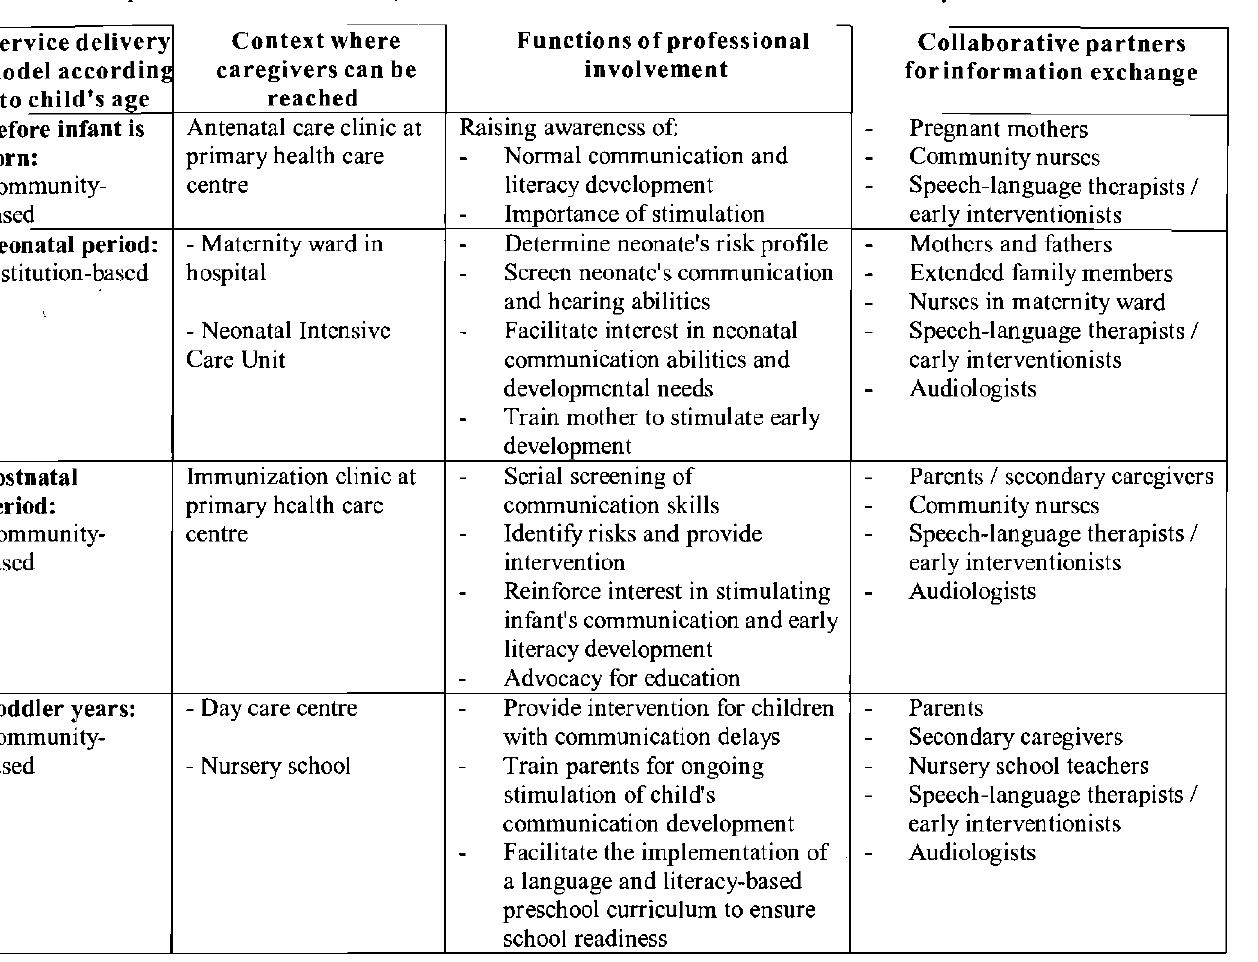
Table 2. Conceptual Framework for Early Communication Intervention Public Service Delivery in South Africa Service